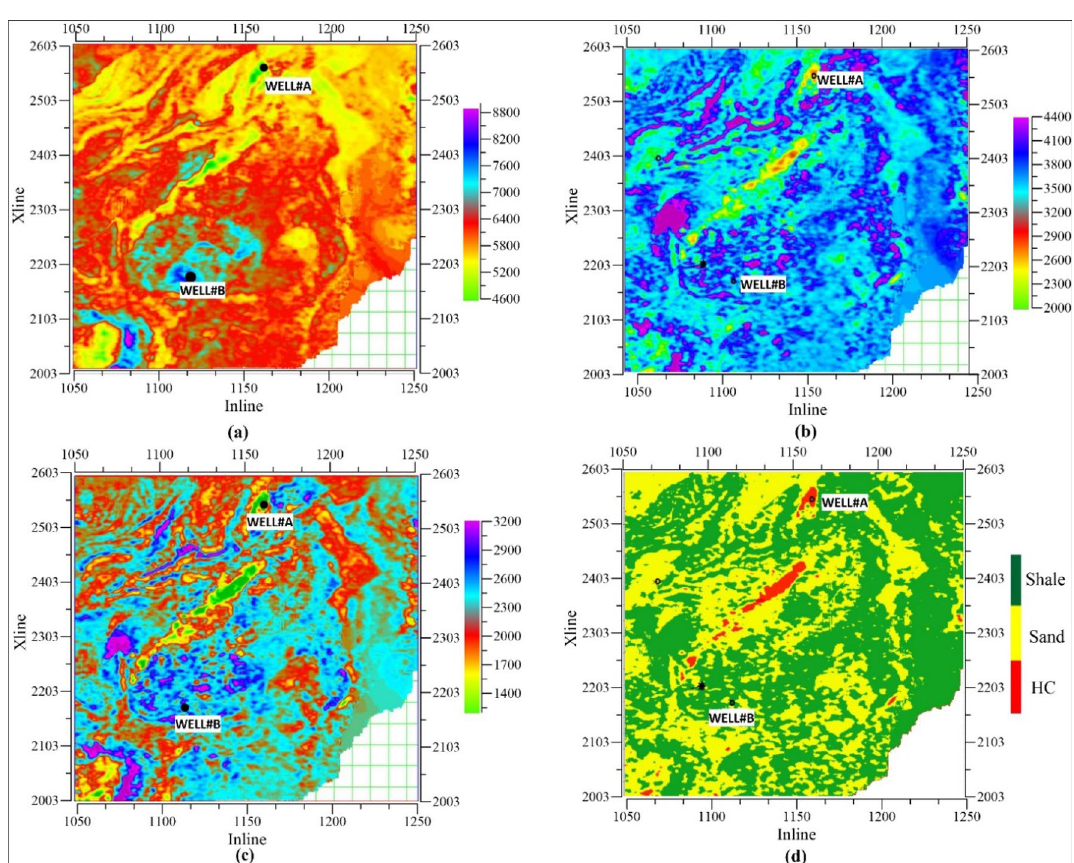
Figure 8. Horizontal slice of seismic attributes ( a ) acoustic impedance ( b ) shear impedance ( c ) Poisson impedance ( d ) Lithofaices at 1820